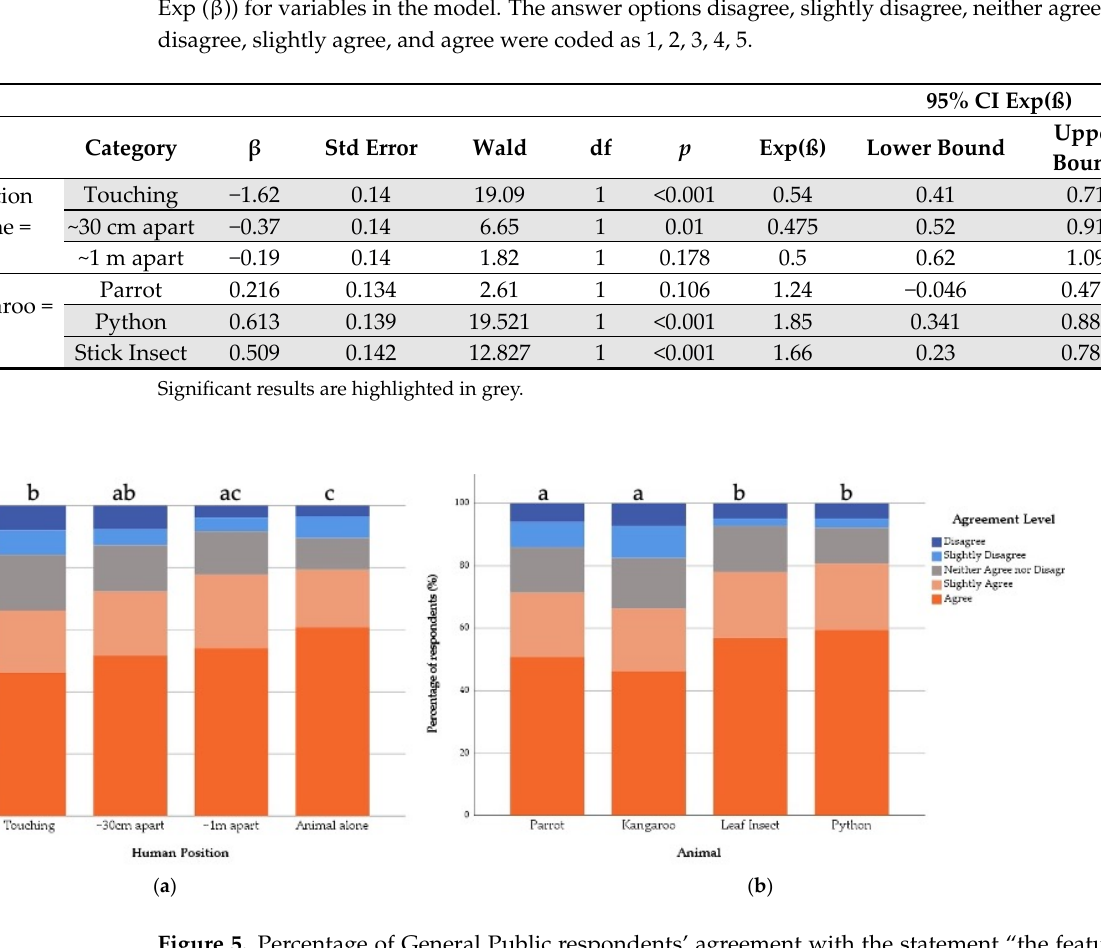
Figure 4. Percentage of Zoo Community respondents’ agreement with the statement “the featured animal is displaying a natural behaviour” in relation to the ( a ) Human Position shown and ( b ) Fea- tured Animal shown. Same letters indicate no statistical difference and different letters indicate sta- tistical differences between variables in the fitted model.